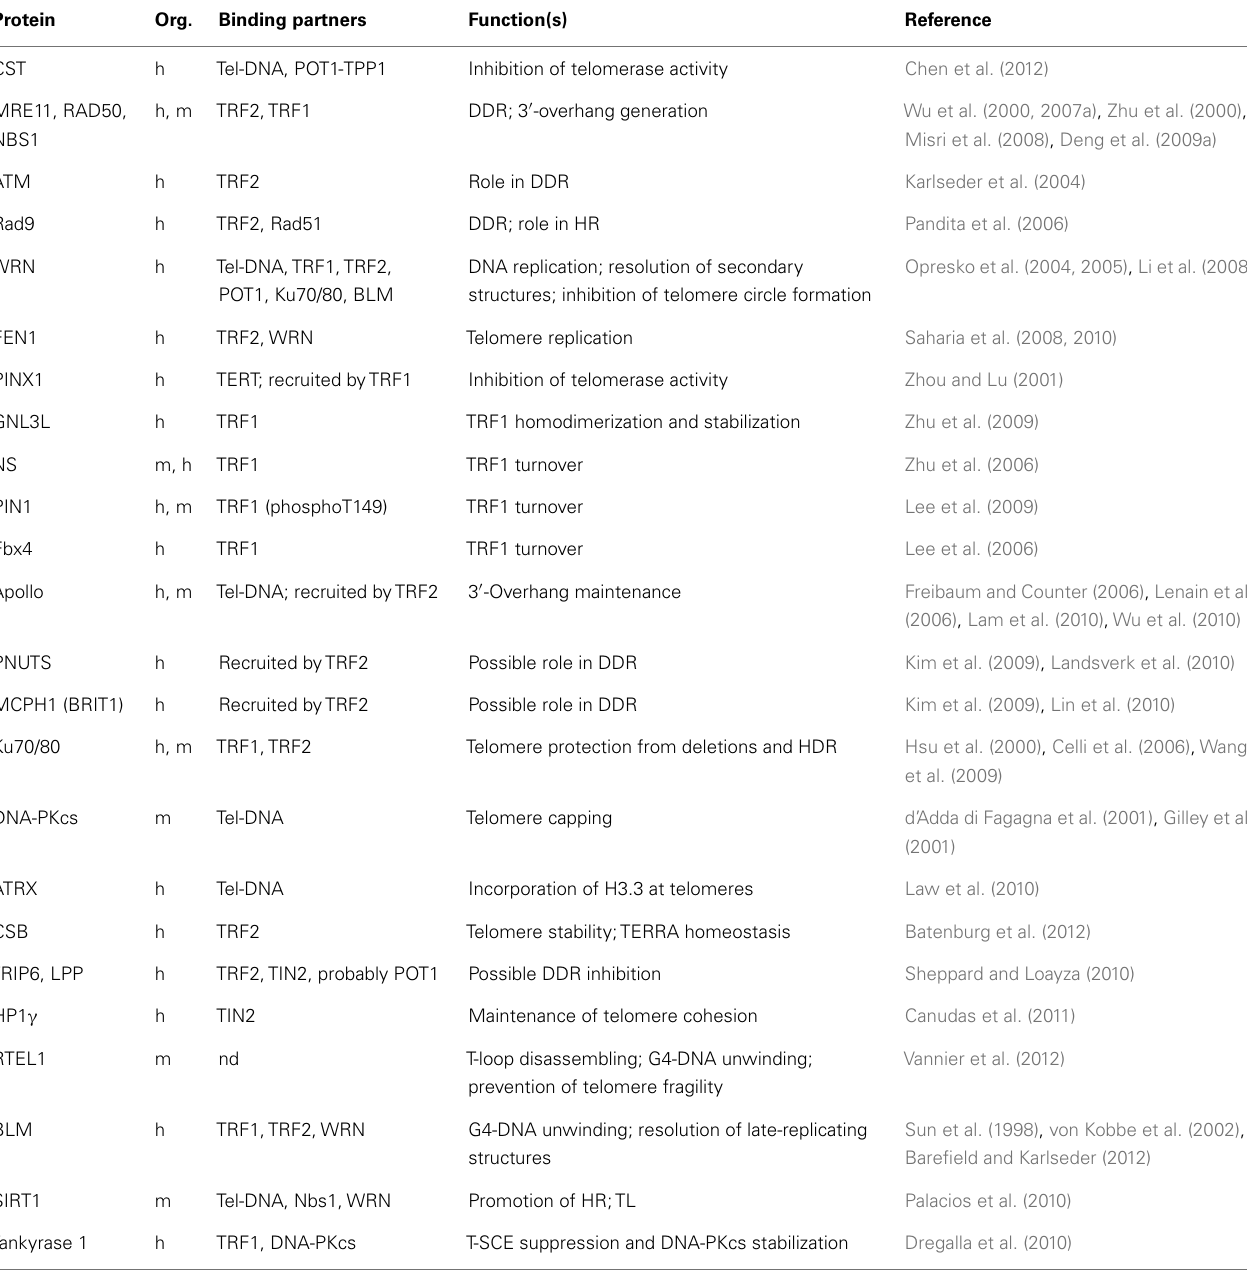
Table 1 | Proteins that interact with telomeric DNA and shelterin components.